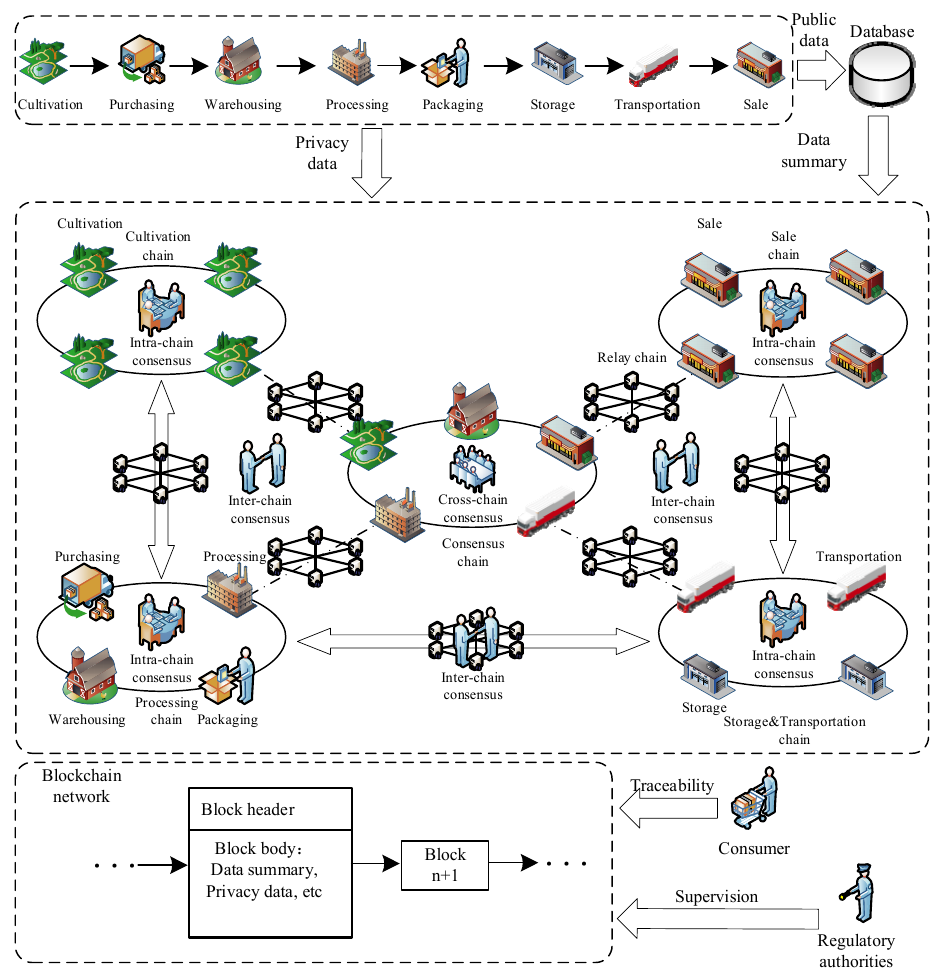
Figure 2. Multi-chain network model of grain food supply chain.